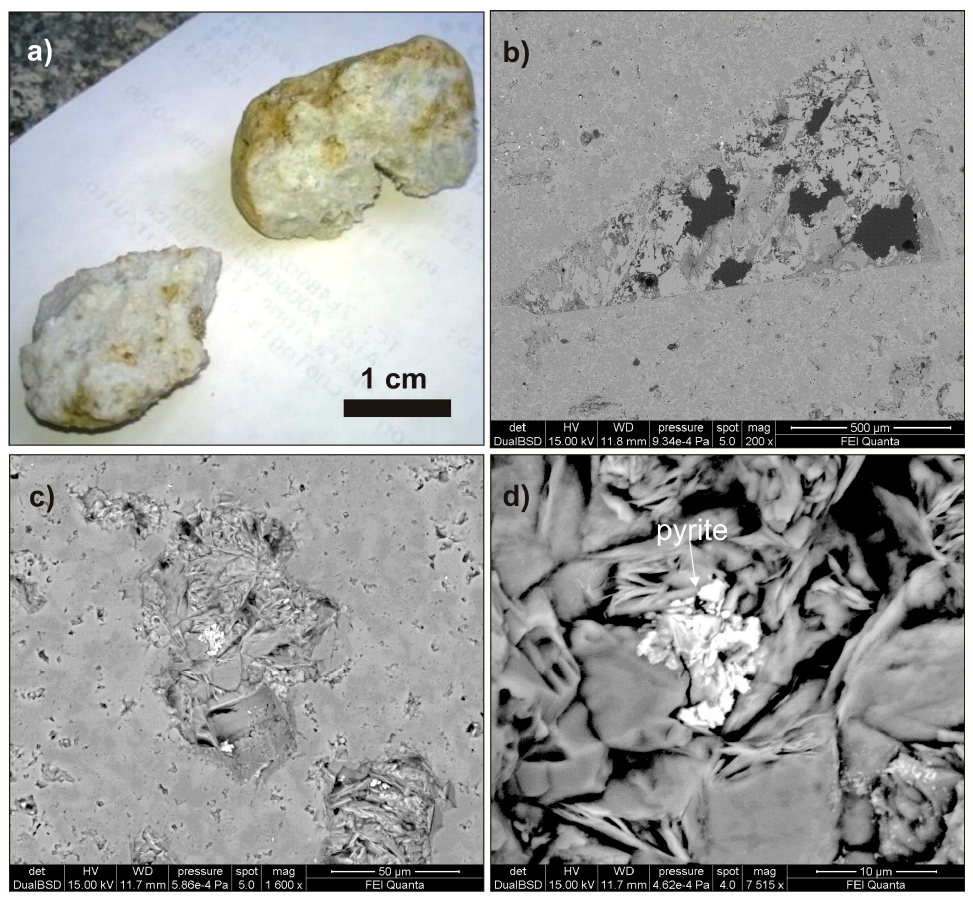
Figure 3. Hand specimen ( a ) and BSE images ( b – d ) of ST2BNR2A quartz-K-feldspar altered rhyolite. Partially sericitized K-feldspar ( b ), patches of phyllosilicates ( c ) including grains of pyrite ( d ) in the quartz-feldspathic matrix.